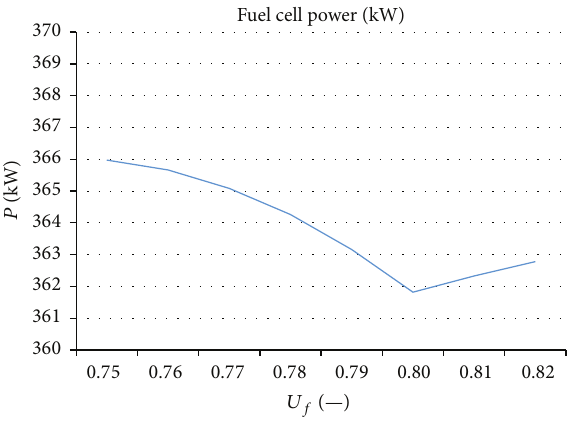
Figure 9: Fuel cell power at varying 𝑈 𝑓